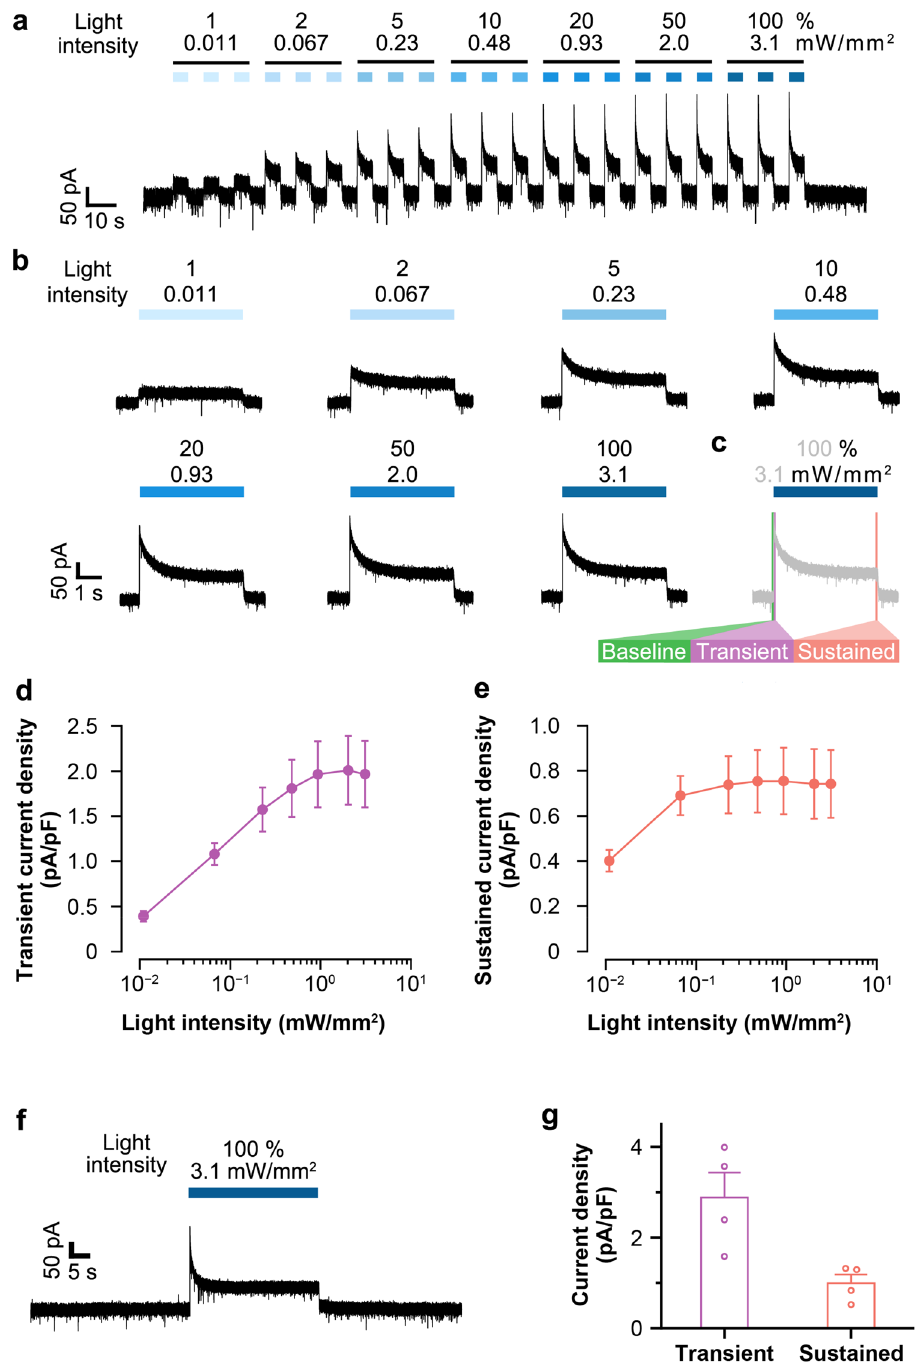
Figure 2. Light-induced photocurrents in ACR2-expressing neurons. ( a ) Representative trace of photocurrent recording with illumination at different intensities of 470 nm light. Membrane potential was held at − 60 mV. Light intensity was adjusted from 1 to 100%, corresponding to 0.011 to 3.1 mW/mm 2 , as indicated above the trace. ( b ) Single trace of photocurrent recording during illumination at different light intensities. ( c ) Definition of baseline, transient, and sustained currents. Baseline: 100 ms before light onset for each illumination. Transient: 100 ms after light onset for each illumination. Sustained: 100 ms before light offset for each illumination. ( d , e ) Transient and sustained current densities as a function of light intensity in ( d ) and ( e ), respectively. Dots show mean values ± SEM of 9 cells from 2 animals. ( f ) Representative trace of photocurrent recording at 470 nm, 30 s light illumination; the membrane potential was held at − 60 mV. Light intensity: 100%, corresponding to 3.1 mW/mm 2 . ( g ) Transient and sustained current densities (n = 4 cells from an animal). Dots show individual